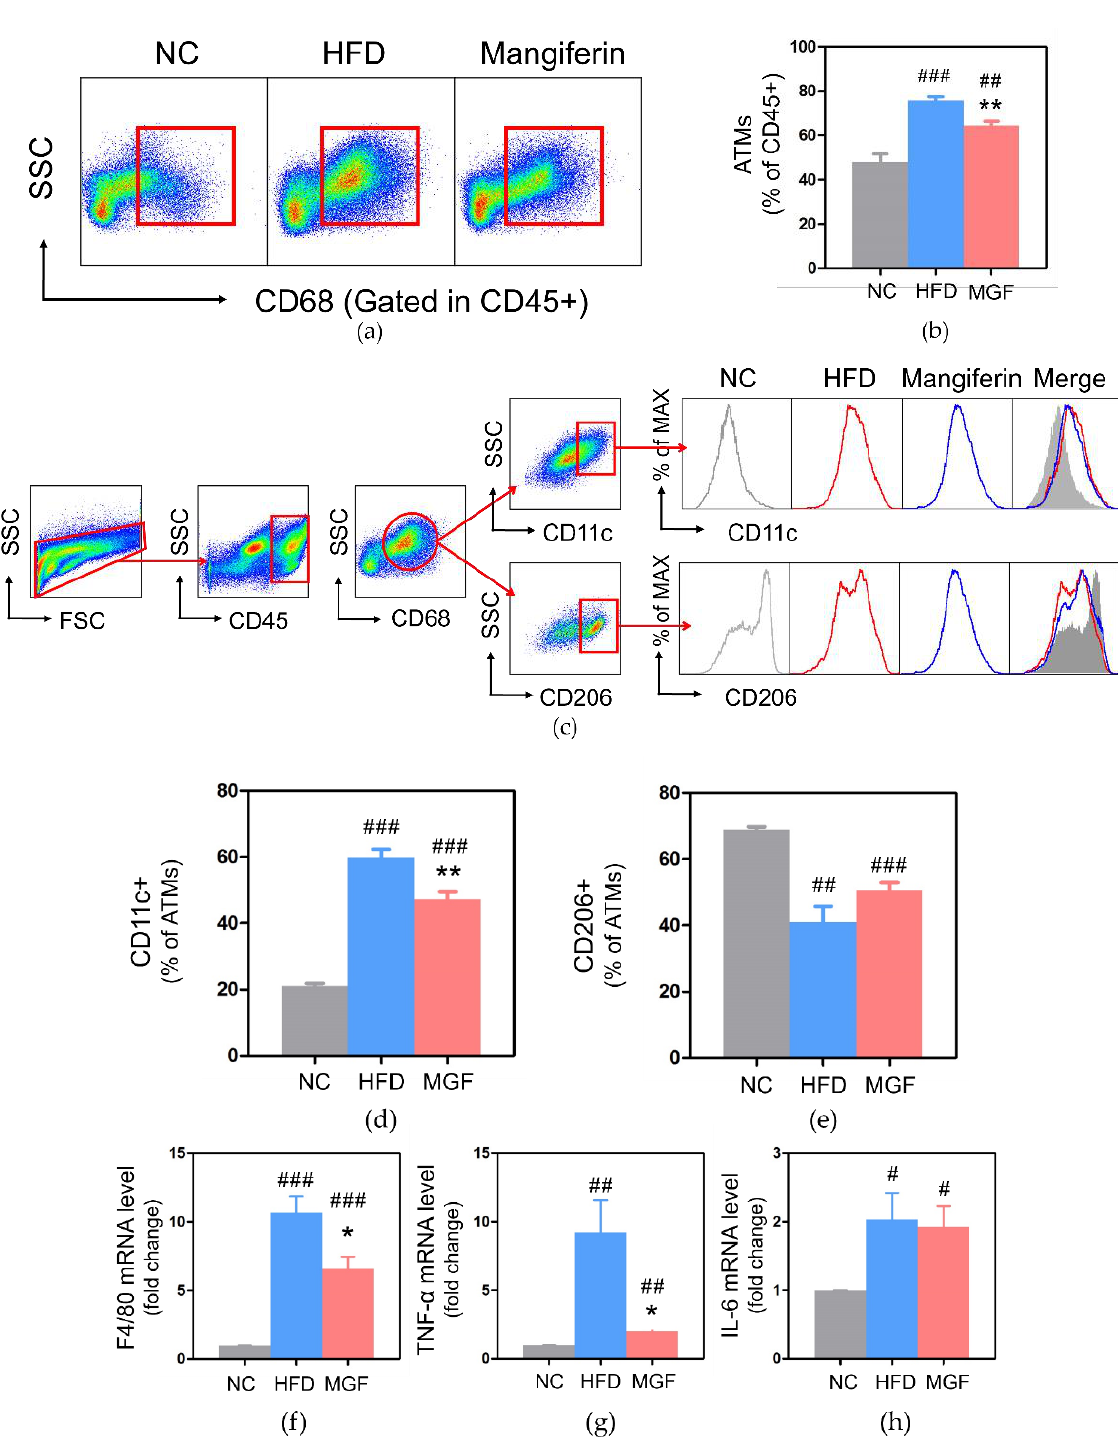
Figure 6. Analysis of ATMs and gene expression of the mRNA level in adipose tissue. ( a ) Flow cytometry of total ATMs. ( b ) Percentage of total ATMs. ( c ) Flow cytometry of CD11c+ and CD206 + ATMs. ( d ) Percentage of CD11c + ATMs. ( e ) Percentage of CD206+ ATMs. Expressions of ( f ) F4/80, ( g ) TNF- α, and ( h ) IL-6. Data are expressed as mean ± standard error of mean. # p < 0.05, ## p < 0.01, and ### p < 0.001 indicate the results of comparison with the NC group, and * p < 0.05, ** p < 0.01 indicates the results of comparison with the HFD group. NC, normal chow; HFD, high-fat diet; MGF, HFD + MGF 150 mg/kg/day; MGF, mangiferin; ATMs, adipose tissue macrophages; TNF- α, tumor necrosis factor- α; IL-6, interleukin-6.